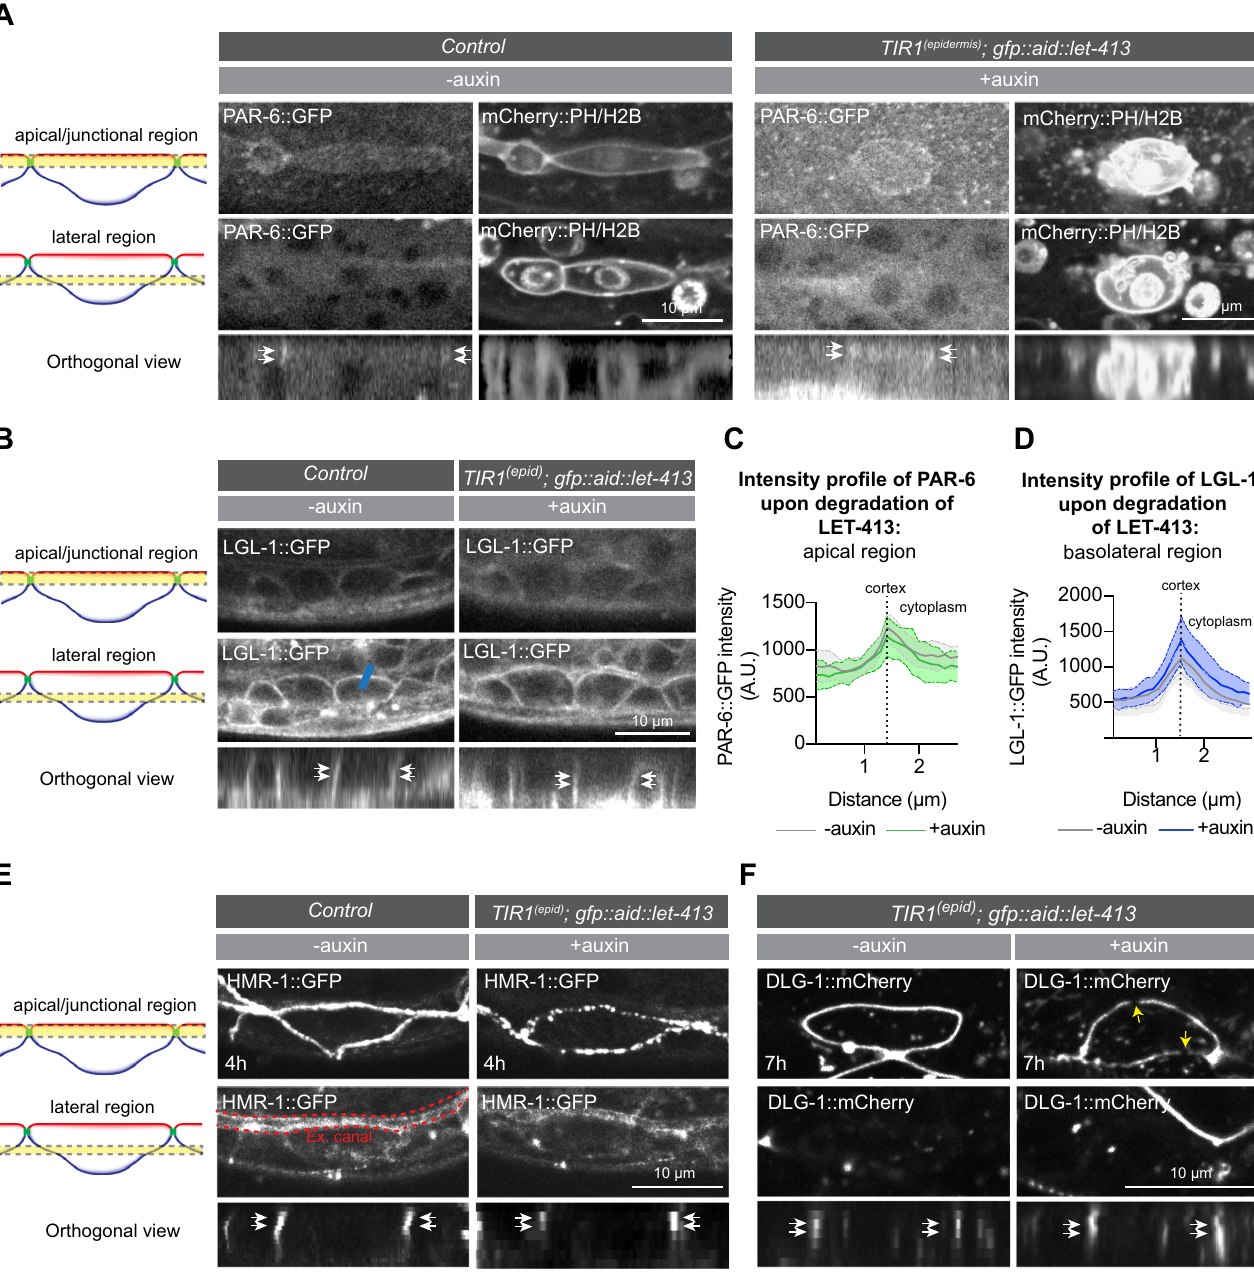
Fig 5. Loss of LET-413 causes junction impairment but does not affect the localization of the polarity regulators PAR-6 and LGL-1. ( A, C ) Distribution and quantification of PAR-6::GFP upon depletion of LET-413 at 5 h post hatching (strain BOX692). As both PAR-6 and LET-413 are fused to GFP and their localization overlaps, the control animals (strain BOX693) do not carry the Pwrt-2 :: TIR1 :: BFP and GFP :: AID :: let-413 gene fusions. Graphs show mean apical GFP fluorescence intensity ± SD at the hyp7–seam cell junction (apical/junctional plane). N = 5 animals for both conditions. ( B, D ) Distribution and quantification of LGL-1::GFP in the epidermis of lgl-1 :: GFP animals without auxin (strain BOX041) and in Pwrt-2 :: TIR1 :: BFP; GFP :: AID :: let-413; lgl-1 :: GFP animals in the presence of auxin (strain BOX694) at 5 h post hatching. Graphs show the mean junctional GFP fluorescence intensity ± SD at the hyp7–seam cell junction (blue bar in D). N = 5 animals for both conditions. ( E ) Distribution of HMR-1 in the epidermis of hmr-1 :: GFP animals (strain SV1955) without auxin (-auxin) and hmr-1 :: GFP; Pwrt-2 :: TIR1 :: BFP; GFP :: AID :: let-413 animals (strain BOX584) in the presence of auxin (+auxin) at 4 h post hatching. ( F ) Distribution of DLG-1:: mCherry in the epidermis of Pwrt-2 :: TIR1 :: BFP; GFP :: AID :: let-413; dlg-1 :: mCherry animals without (-auxin) and in the presence of auxin (+auxin) at 7 h post hatching (strain BOX585). Yellow arrows indicate gaps in the normally continuous DLG-1::mCherry